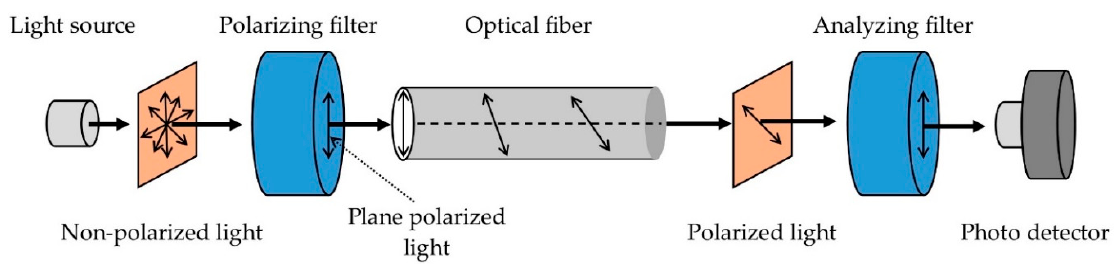
Figure 6. Components and working principle of optical-based goniometer system. The system was composed of five components: (1) a semiconductor laser as light source, (2) a Si p–i–n photodiode as photo detector, (3,4) two linear polarizers as polarizing and analyzing filters, and (5) a single-mode optical fiber as stress-induced birefringence polarization controller (SIBPC).